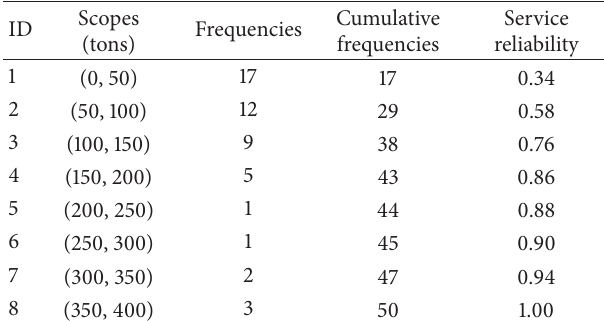
Figure 6: The flow chart of a real hybrid system with belt and surge bin. Table 3: The second output result of the simulation